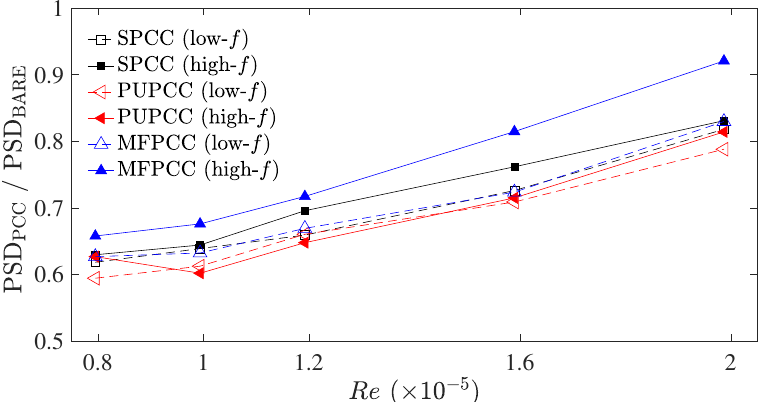
Figure 9. Magnitudes of the lower-frequency and higher-frequency tone magnitudes, PSD PCC , relative to the bare cylinder shedding tone magnitude, PSD BARE